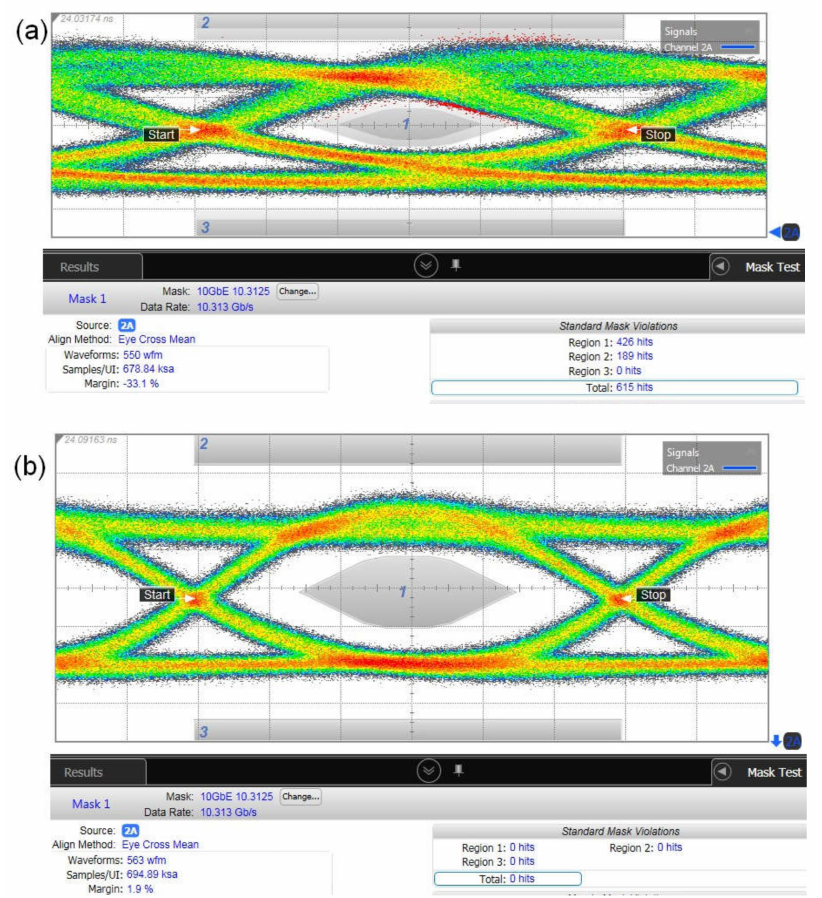
Figure 4. Eye diagrams of the devices under a direct modulation rate of 10 Gb / s. ( a ) Un-doped device and ( b ) p-doped